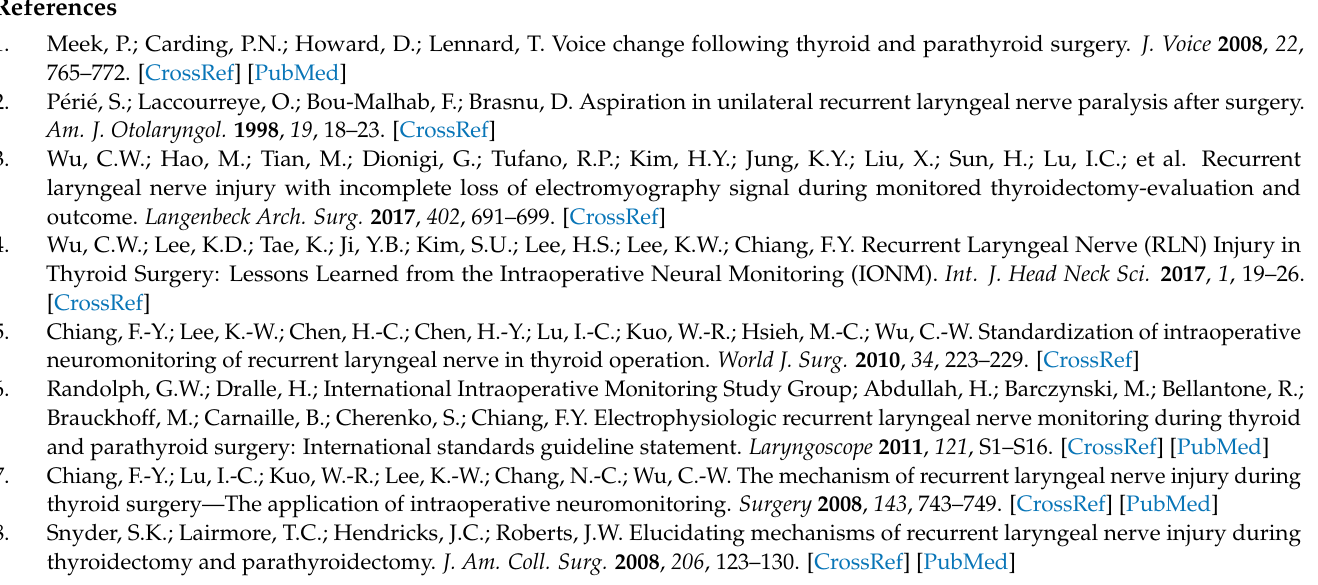
Table S2. Comparison of voice parameters of Group A, B and C in each follow-up